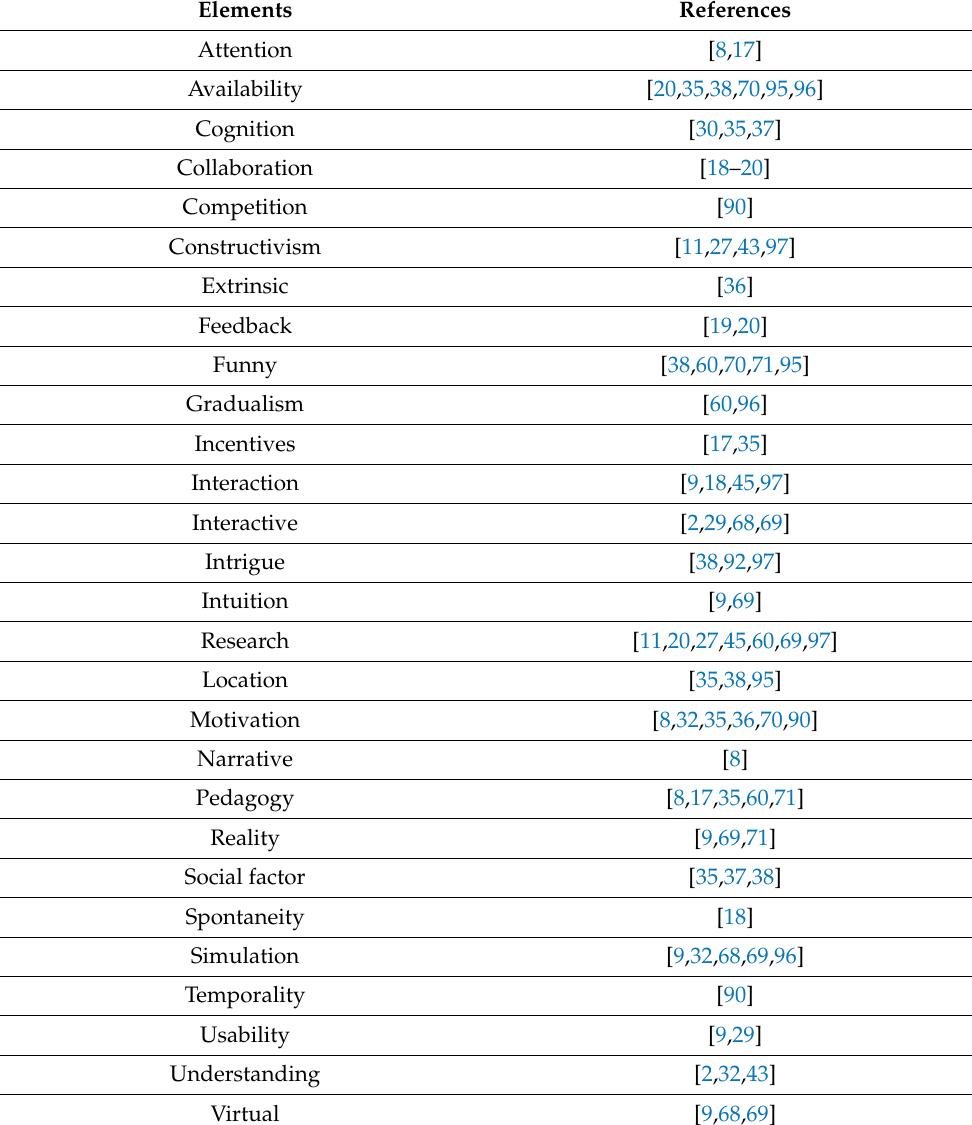
Table 4. Tool elements for enjoyable, interesting, and intriguing